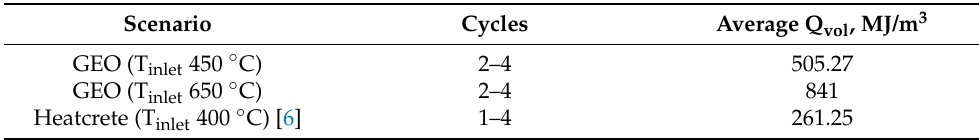
Table 5. Comparison of Q vol for GEO and Heatcrete